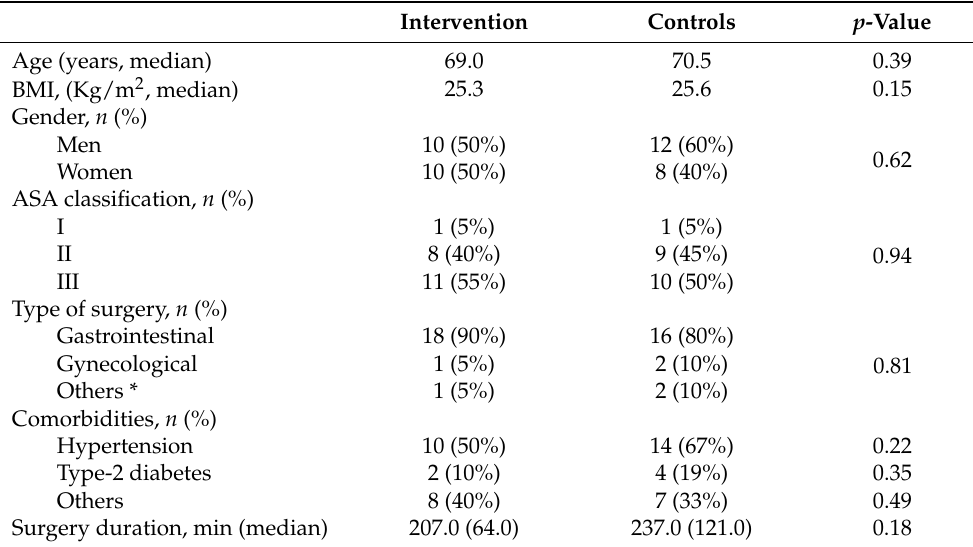
Table 1. Background characteristics of the intervention and control groups. ASA: American Society of Anesthesiologist. BMI: Body Mass Index. * Included nephrectomy and removal of abdominal liposarcoma.